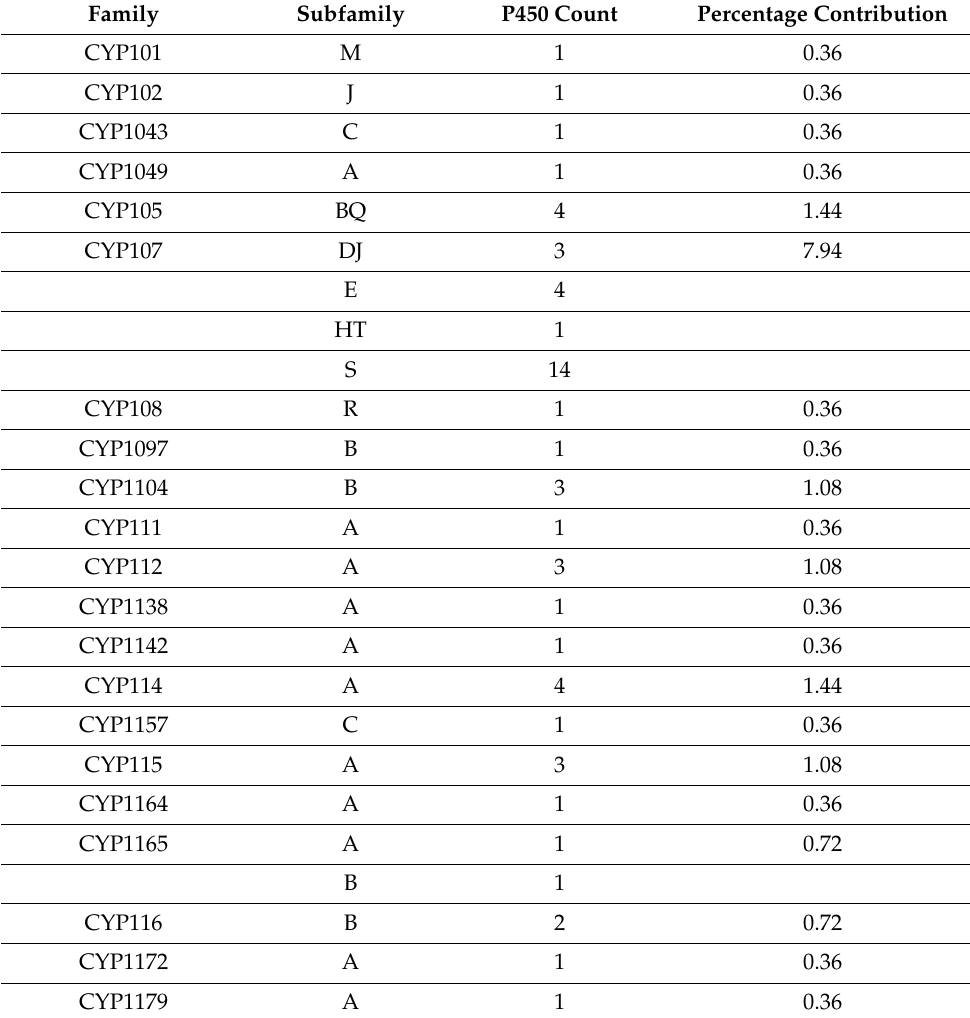
Table 3. Comparative analysis of P450 families and subfamilies in Gammaproteobacterial